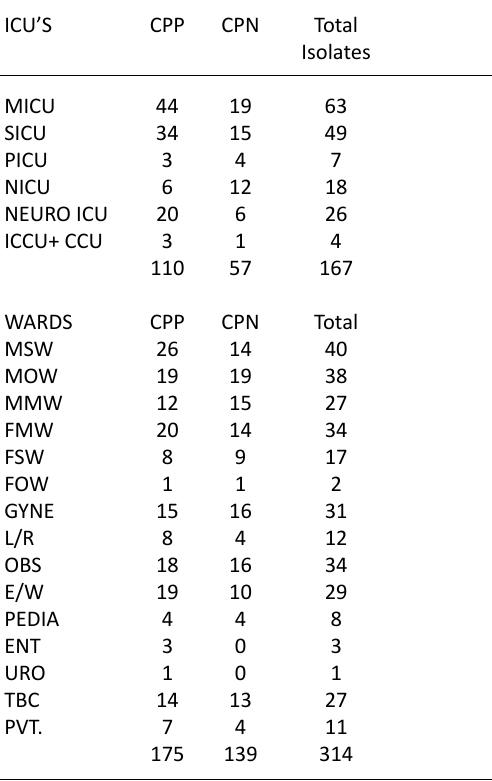
Table 5. Distribution of Number of Carbapenemase Producing and Non Carbapenemase producing isolates from different wards